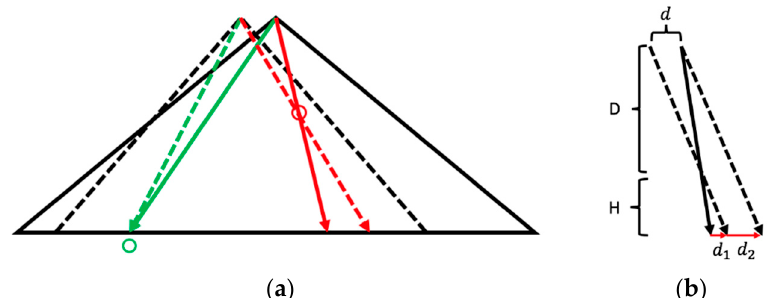
Figure 5. The diagram showing the lens spacing error. In ( a ), the solid triangle and the dashed triangle represent the FOV of the visible and the thermal lens, respectively. The thermal lens FOV is narrower and is to the left of the visible lens FOV when the camera is in forward motion. For the object located on the ground (green cycle), the sight lines of the visible lens (solid green arrow) and the thermal lens (dashed green arrow) both point to the object on the ground (green circle), and for the object above the ground (red circle), the intersection point of the sight lines (solid red and dashed red arrows) is elevated. In ( b ), the solid and the dash arrows are the sight lines of the visible and the thermal lenses, respectively, where d is lens spacing, D is distance between the on-board camera and the object being observed, H is the height of the object above the ground, and d 1 and d 2 refer to two different contributors of Lens Spacing Error.